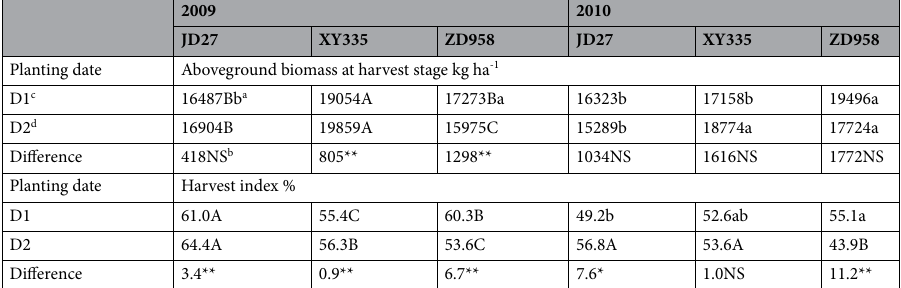
across hybrids, with similar grain yield between XY335 and ZD958 at D1 in 2009, they produced significantly greater grain than JD27. With similar grain yield between JD27 and XY335 at D2 in 2009, they showed signifi-